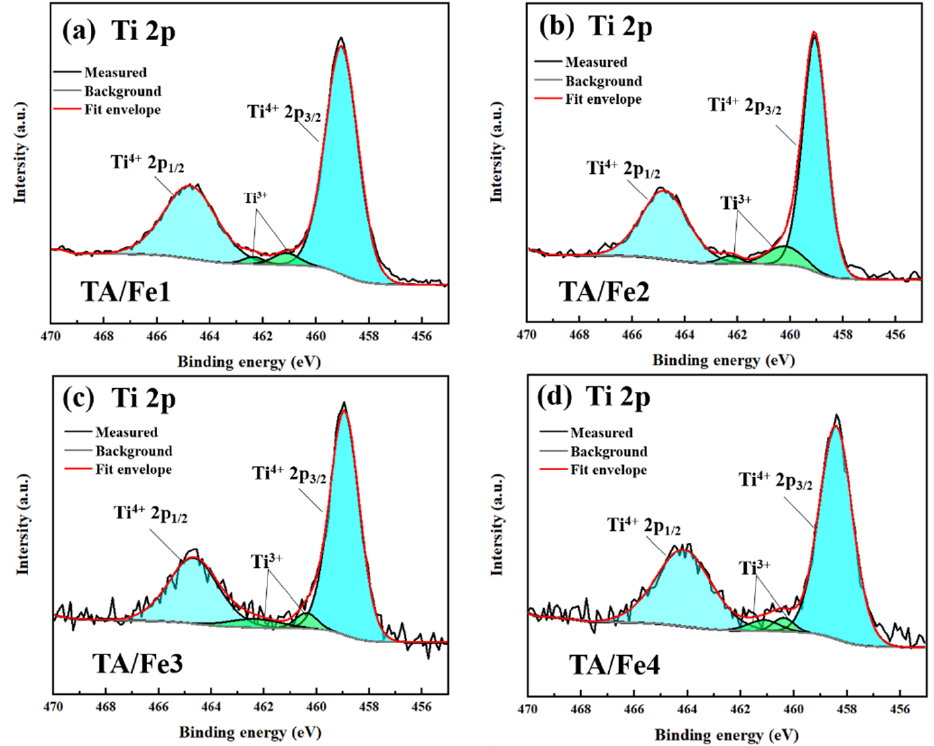
Figure 6. Ti 2p XPS spectra of the titanium oxide-based aerogel catalysts doped by different Fe sources: ( a ) TA/Fe1, ( b ) TA/Fe2, ( c ) TA/Fe3, ( d ) TA/Fe4.